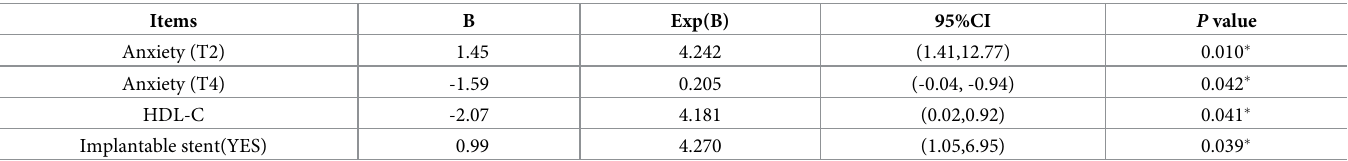
Table 9. Logistic regression analysis of influencing factors on readmission rate.